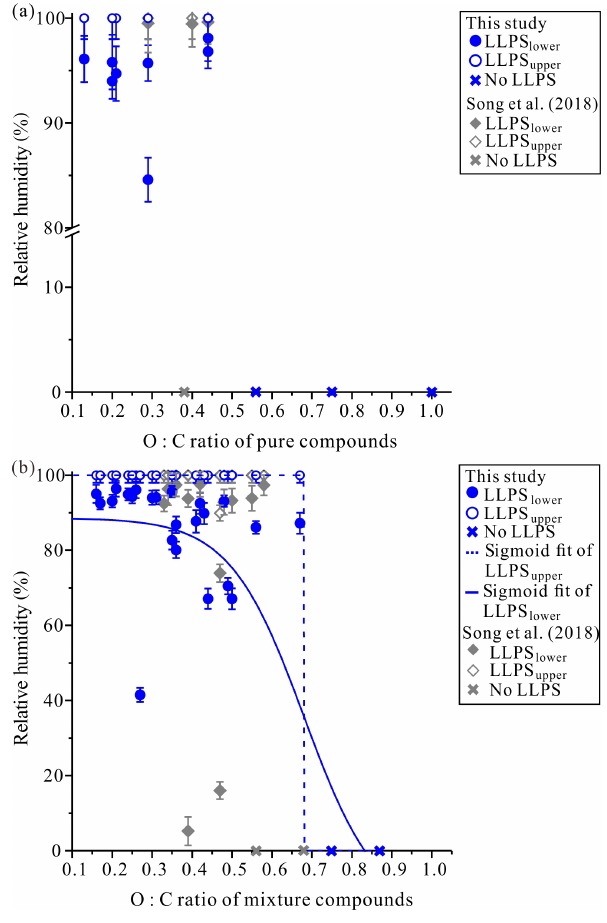
Figure 3. Relative humidity (RH) for LLPS as a function of the O : C of the organic particle consisting of (a) one organic species and (b) two organic species for increasing RH. Open blue circles are the LLPS upper boundary (LLPS upper ) with increasing RH, and closed blue circles are the LLPS lower boundary (LLPS lower ) with increasing RH. Each data point includes four to five particles within particle size ranges from 30 to 100µm. The gray diamonds repre- sent the result from Song et al. (2018). Error bars represent 2 σ of multiple measurements and the uncertainty from the RH calibra- tion. The solid and dashed lines are Sigmoid–Boltzmann fits to all the data of LLPS lower and LLPS upper